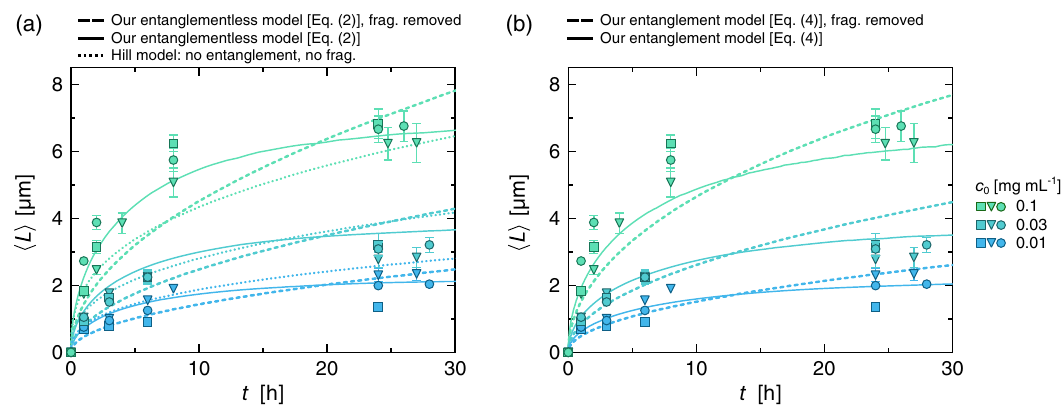
FIG. 2. Comparison of different models at low concentrations ( c ¼ 1 , 3, 10 equivalent to 0.01, 0.03, and 0 . 1 mg mL − 1 in experiments). (a) Models without entanglement. Dashed lines: our model, i.e., K 0 ). Solid lines: our model with fragmentation; K ( K d ¼ 0 ). (b) Models with entanglement. Dashed lines: model without fragmentation ( K ( K d ¼ 1 . 0 × 10 − 3 ; γ ¼ 7 × 10 − 6 ). The values of K fragmentation ( K d ¼ the best-fit estimates obtained by fitting each experimental